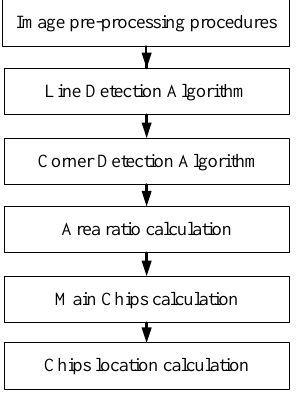
Figure 12. Module image recognition process.